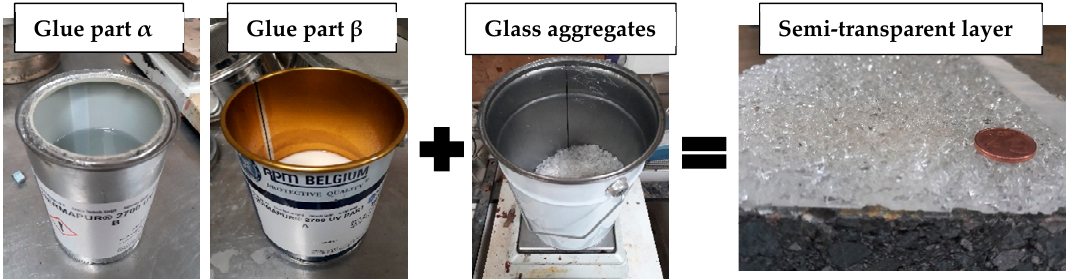
Figure 2. Manufacturing process of the samples.